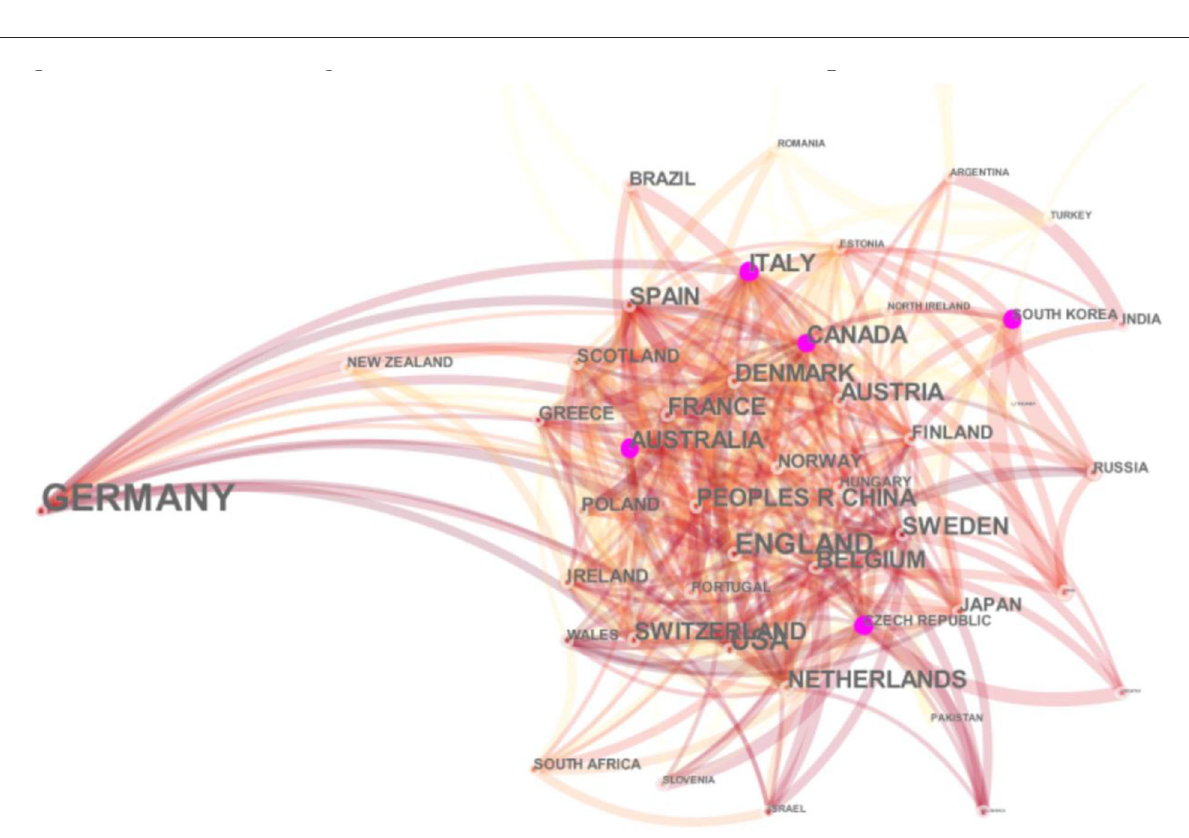
FIGURE2 Schematic diagram of the German international cooperation network in environmental research. Source: This map was drawn by the author through CiteSpace.